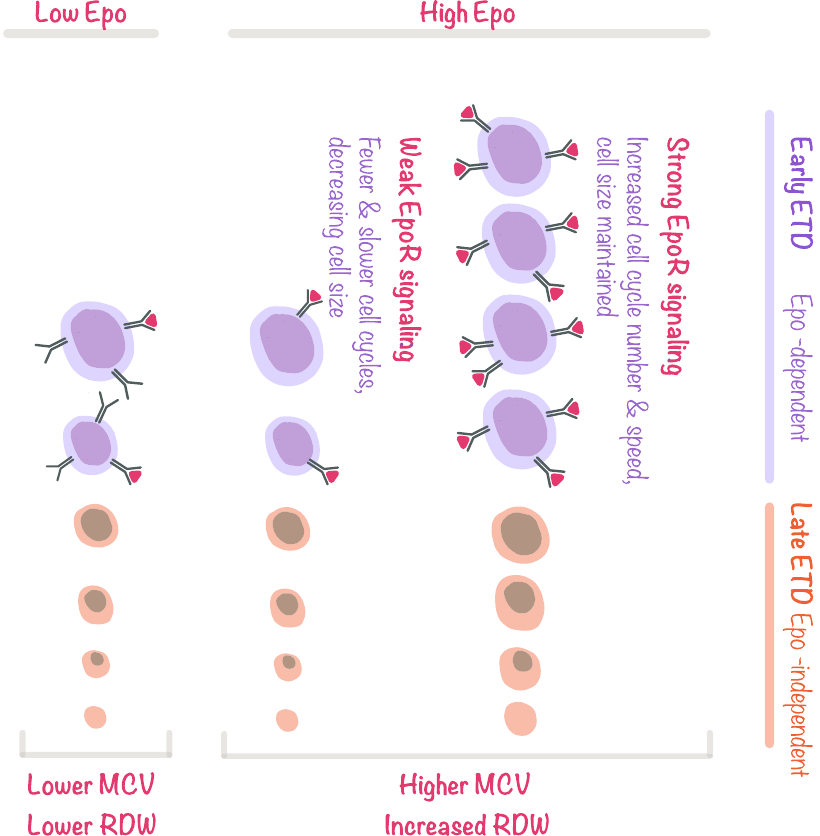
Fig. 7 EpoR signaling promotes rapid cycling while maintaining cell size in early erythroblasts. Proposed model explaining EpoR-dependent functions during ETD. EpoR expression is limited to early erythroblasts, which are sensitive to EpoR signaling. When EpoR signaling is weak or absent, as in late erythroblasts, or in early erythroblasts in the presence of low Epo, cell divisions lead to cell size reductions. In contrast, strong EpoR signaling, as seen in Epo-sensitive early erythroblasts, can override this default state, simultaneously increasing rapid cycling while maintaining cell size. As consequence, high- Epo levels increase the duration of the early ETD phase, increase the relative frequency of early erythroblasts, and also increase erythroblast cell size at every maturation stage, giving rise to larger red cells. In high Epo, red-cell size is also more heterogeneous, a result of the varying sensitivities of early erythroblasts to Epo. Erythroblasts with low sensitivity to Epo, here represented as cells expressing low levels of EpoR, receive only weak EpoR signals even in the presence of high Epo, giving rise to smaller red